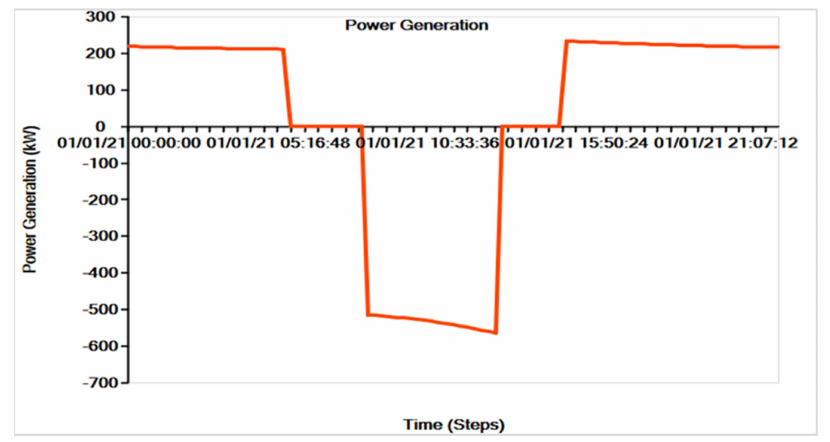
Figure 16. Lithium-ion power generation